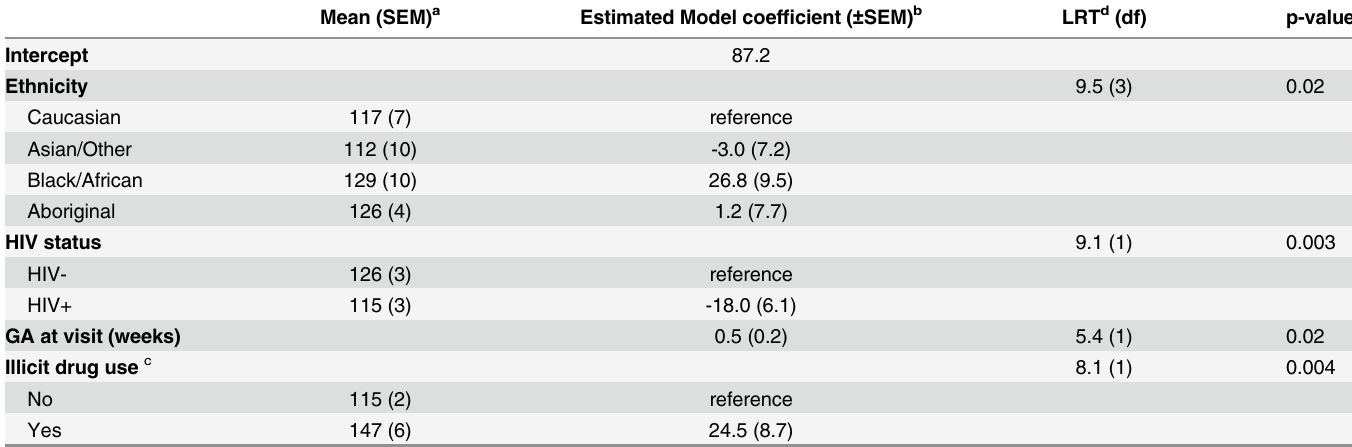
Table 5. Means, model estimates, and log-likelihood ratio test Chi-squared results for the mixed-effects modelling of mtDNA levels in all HIV+ and HIV- pregnant women (n =